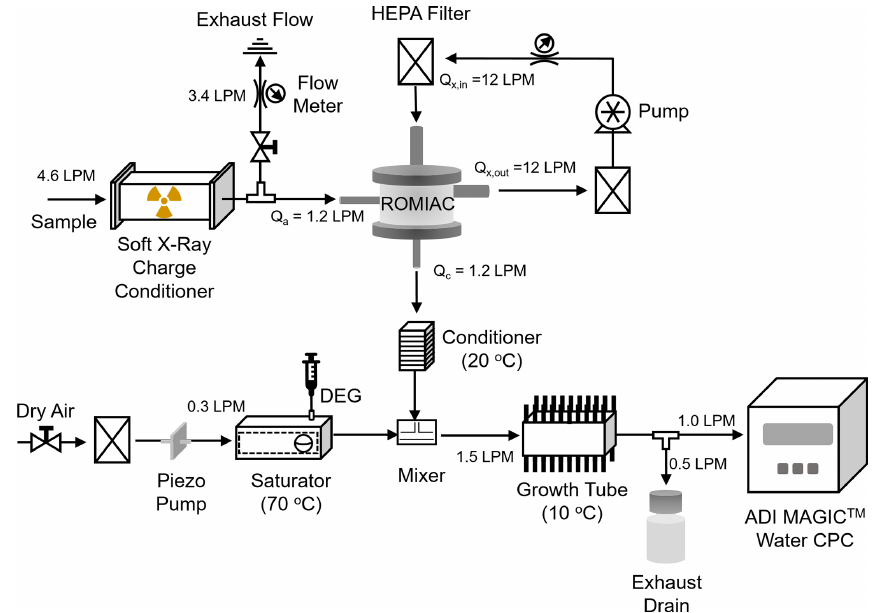
Figure 1. Schematic of the nSEMS main components: a radial opposed-migration ion and aerosol classifier (ROMIAC) and a two-stage condensation particle counter (CPC). The aerosol enters the nSEMS after passing through a soft x-ray CC at a high flow rate (4.6Lmin − 1 ). Core sampling of that input sample flow is employed to minimize particle diffusional losses in the transport tubing and the CC. The ROMIAC is operated on exponentially increasing voltage ramps between 20 and 10000V of both positive and negative polarity at 1.2 and 12Lmin − 1 aerosol and cross-flows (Table 1). After exiting the classifier, monodisperse aerosol particles are mixed with 0.3Lmin − 1 diethylene glycol (DEG) vapor in the first stage of the CPC. This fast-mixing stage allows nanoparticles to grow through rapid vapor condensation before they enter the second “booster” CPC stage, a modified Aerosol Dynamics Inc. (ADI) MAGIC™ water CPC operated at a flow rate of 1.0Lmin − 1 , in which particles grow further and are optically